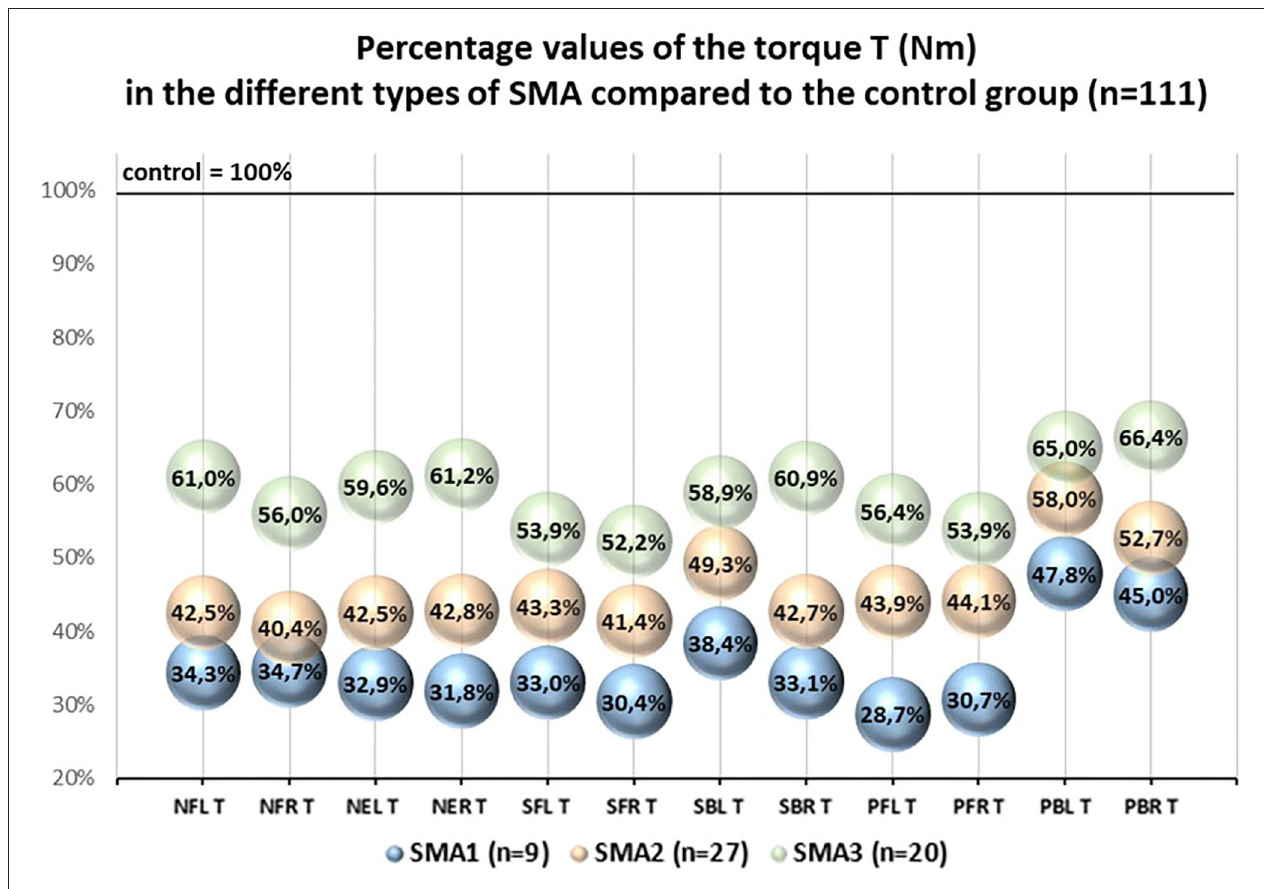
FIGURE 2 | Pecentage values of the torque T (Nm) in the different types of SMA compared to the control group ( n =